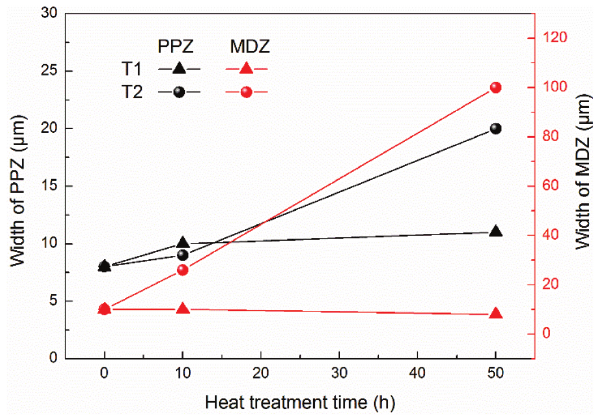
Figure 10: Change in the width of the PPZ and MDZ with heat treat- ment time.